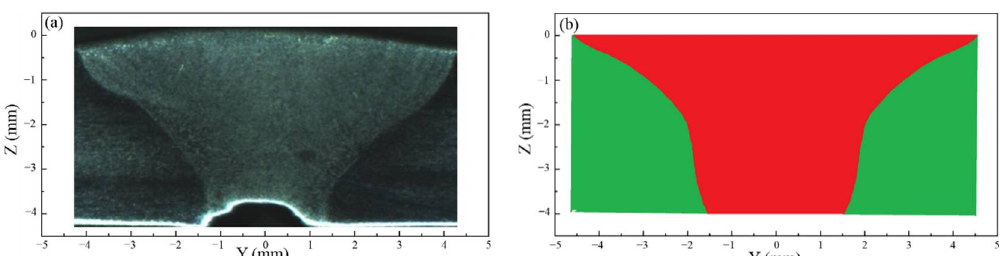
Figure 11. Weld cross section of U-PAW ( a ) measured ( b ) calculated. Table 3. Comparison of the experimental and calculated results.